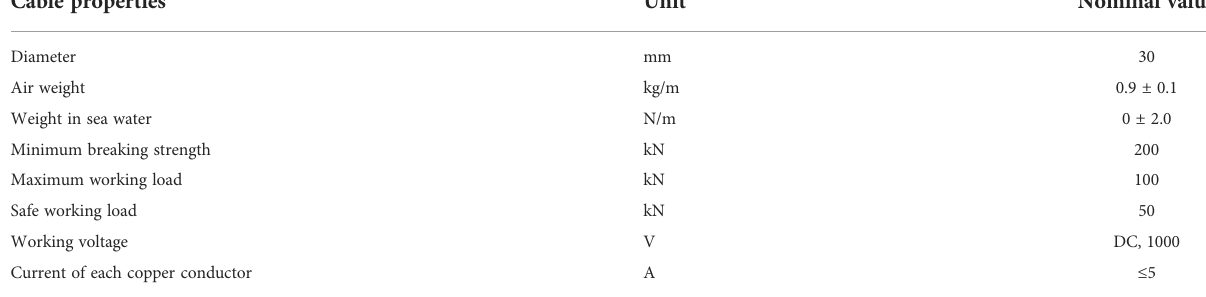
TABLE 4 Properties of the EOM